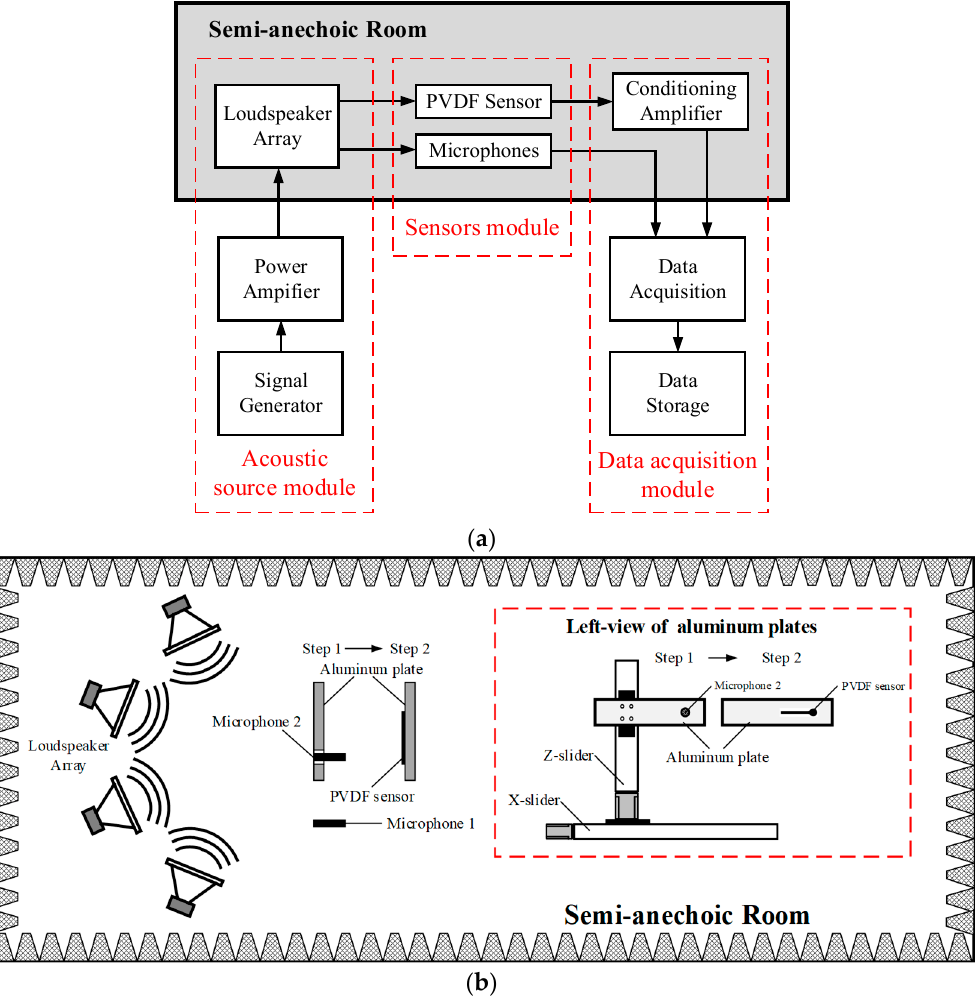
Figure 4. Schematic diagram of the calibration apparatus: ( a ) block diagram of the calibration system. ( b ) detailed schematic diagram in semi-anechoic room.